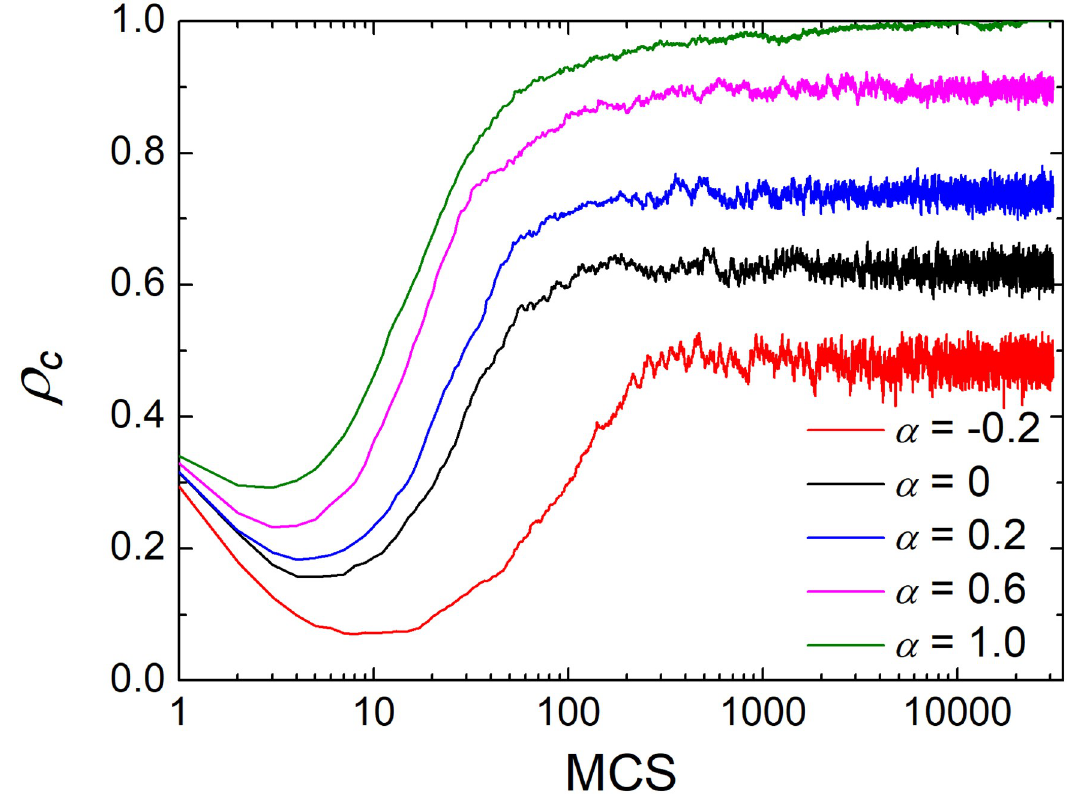
Fig 4. Time series of cooperation for the different values of α . All the results are obtained for the enhancement factor r = 4.2 and the memory length M = 1. The size of square lattice is 100 × 100.